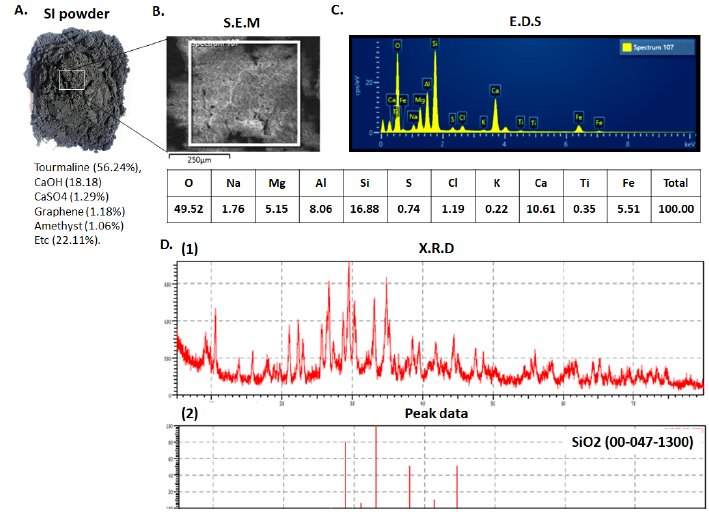
Figure 1. SI powder characterization. ( A ) SI powder fabrication. ( B ) SEM image shows powder morphology. ( C ) EDS shows compounds of SI powder fabric. ( D ) ( 1 ) XRD peaks of SI powder fabric and ( 2 ) peaks of SiO 2 among SI powder compounds.